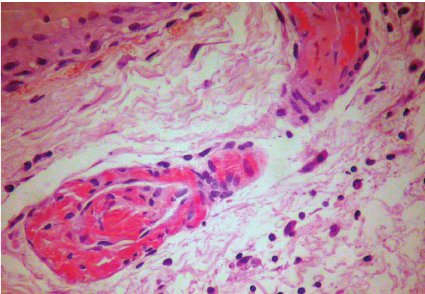
Figure 2: Perivascular amyloid deposit in colon submucosa (Congo red staining without polarization).